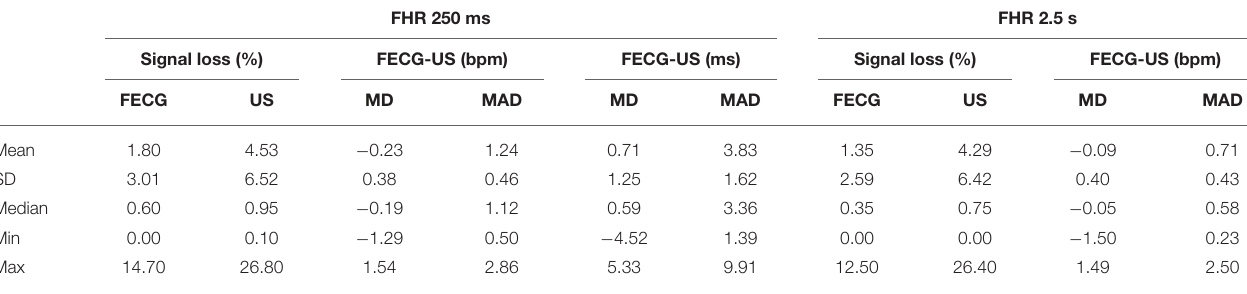
TABLE 1 | Descriptive statistics of the signal loss and values of differences MD, MAD, determined for the final set of recordings from the electrocardiography (FECG) and the ultrasound method (US), where the FHR signals were expressed as the original 250 ms measures, and as the values averaged over 2.5s